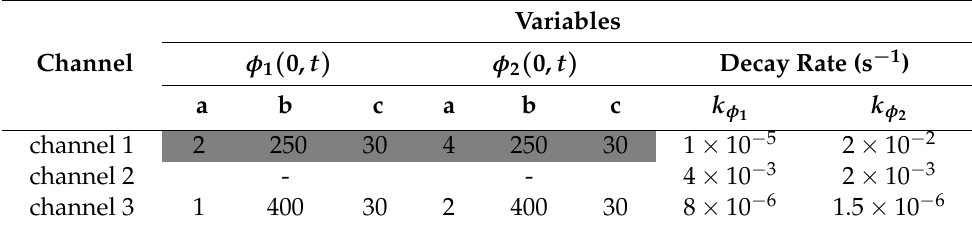
Table 3. Case 6. Gaussian function parameters and decay rates of the three channels.